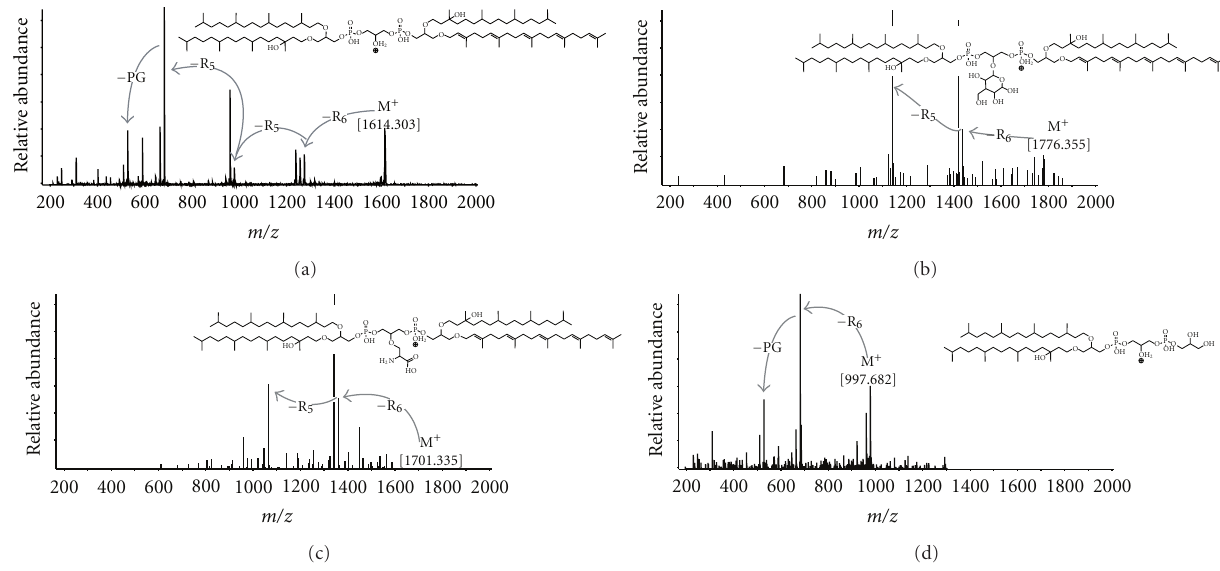
Figure 2: Positive mode MS 2 spectra of novel archaeal IPLs analyzed by HPLC-ESI-MS. (a) Representative BPG (OHC 20:0 /OHC 20:0 /C 20:0 /C 25:5 -BPG); (b) glycosylated BPG; (c) serine BPG; (d) PGPG-OH-AR. Losses are indicated by R n (Figure 1(d)). Detailed information on major ions in MS 2 spectra is available in Table